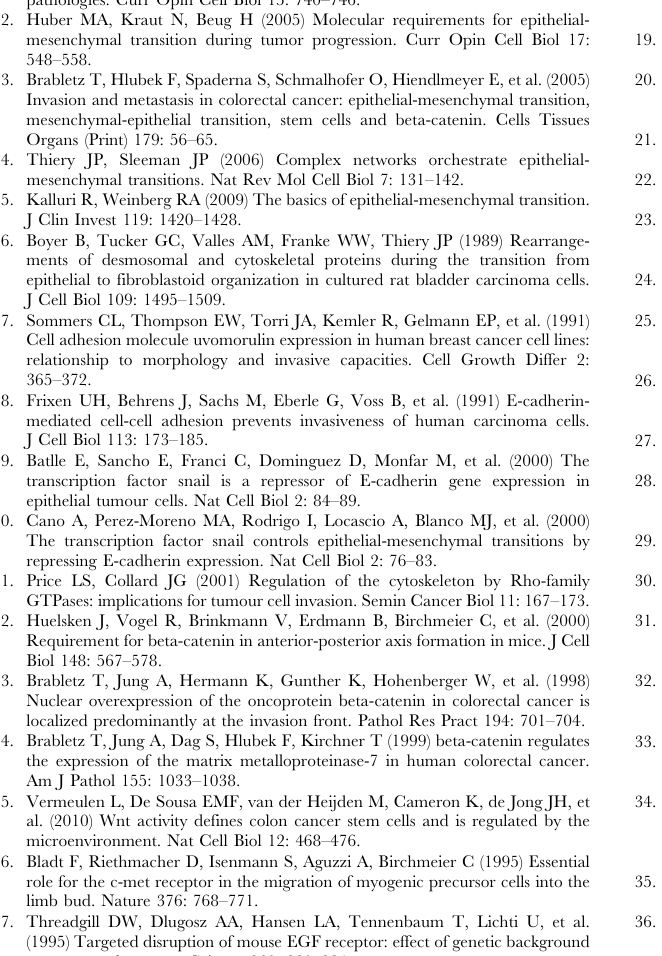
Figure S8 TCF7L1 expression is delocalized and upre- gulated in human colon carcinoma. Expression of TCF7L1 in normal human colon (upper panel), primary human colon carcinoma (middle panel), and lung metastasis of human colon carcinoma (lower panel), as assessed by RNA in-situ hybridization. Negative control hybridization (using an unrelated asRNA probe of similar size and CG content) did not produce a signal (not shown). Table S1 Full list of genes that were targeted by esiRNA in the loss-of-function phenotypic screen. Table gives Gene Symbols, ENSEMBL IDs, esiRNA information and comments on screening results. Bold Gene Symbols correspond to current ENSEMBL IDs (GRCh37.p3, release 62), Gene Symbols in regular type may correspond to previous